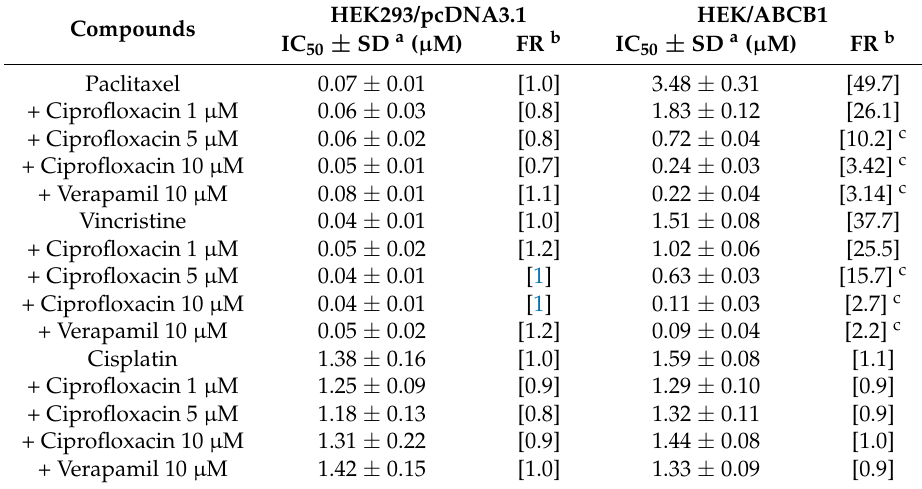
Table 2. The effect of ciprofloxacin on reversal of ABCB1-mediated MDR.